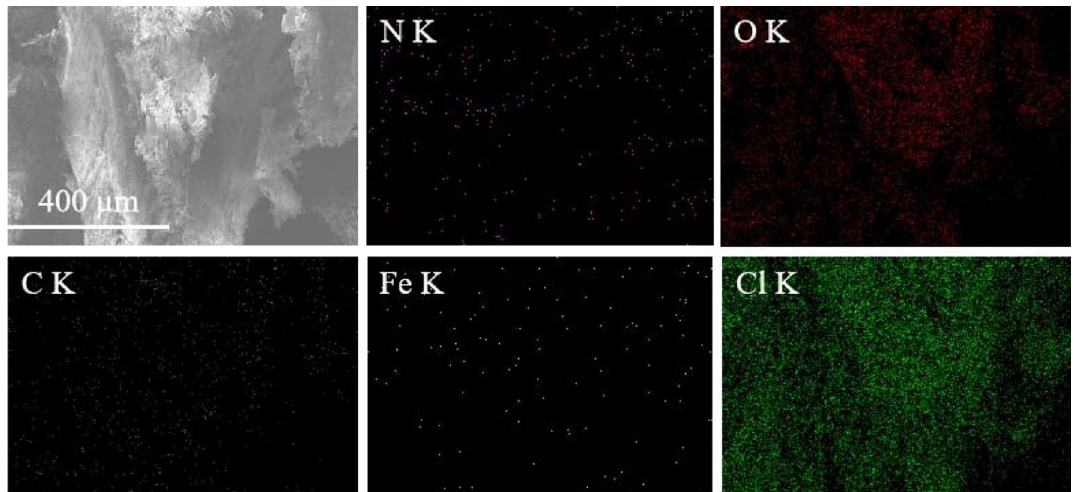
Figure 3. SEM images of laminated AP composite and corresponding EDS results.